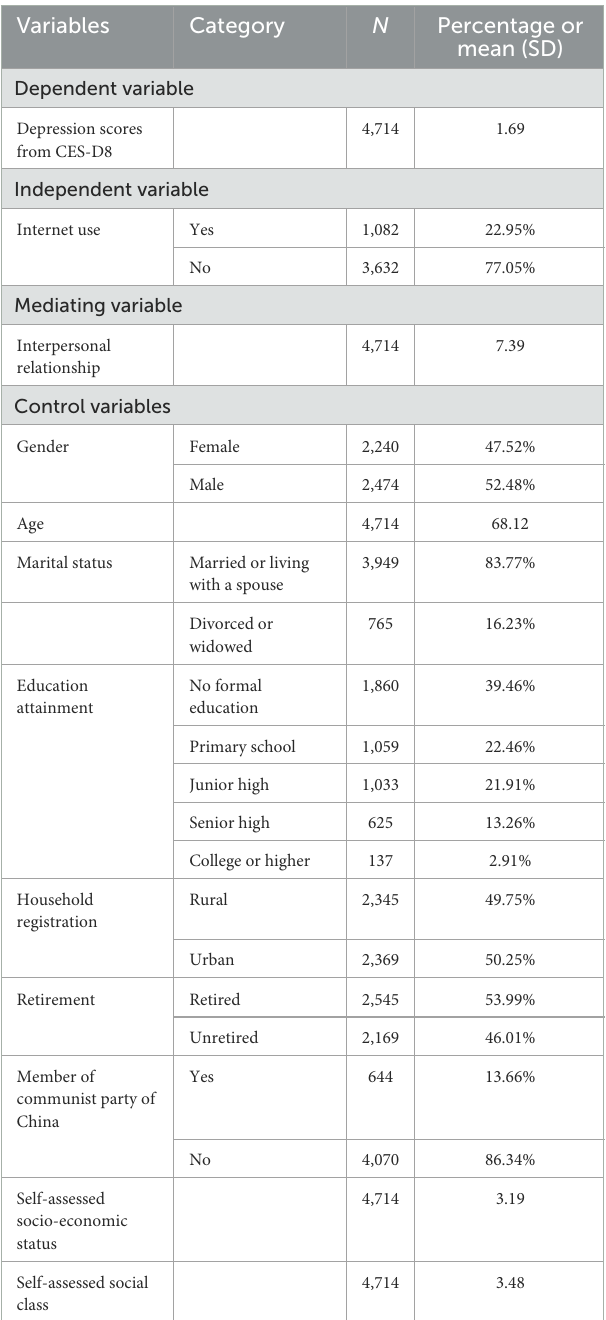
TABLE 1 Basic characteristics for